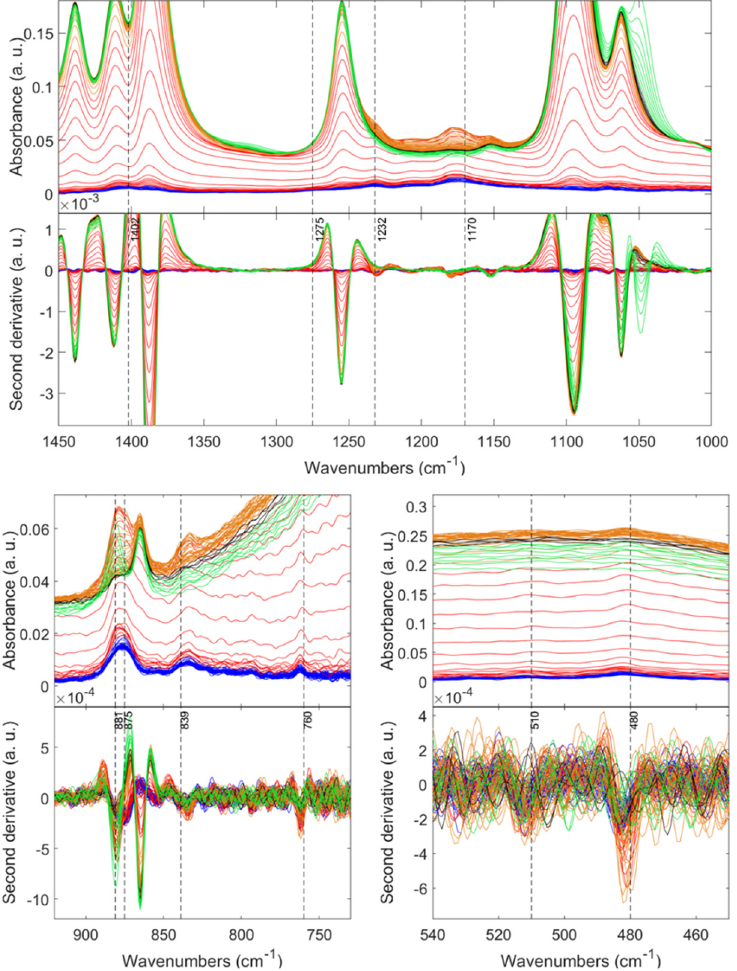
Figure 9. In situ FTIR spectra of the P12E0.2H0.86 solution during the cooling–gelation process (80 °C to RT). For appreciation reasons, the patterns were colored by stages from the beginning to the end: green, black, orange, red, and blue.